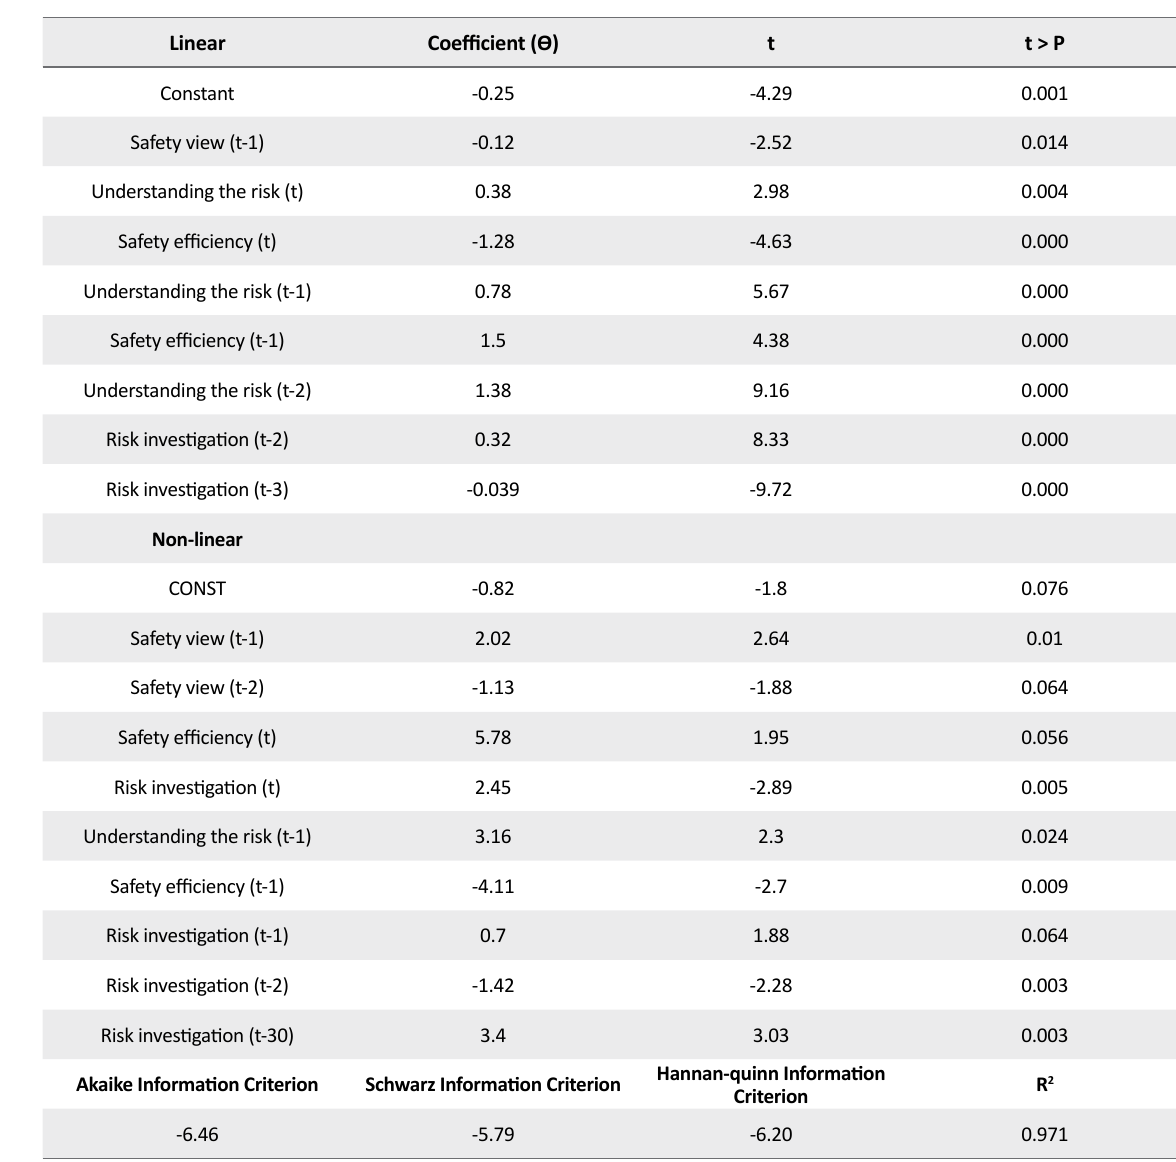
Table 7. The final estimation of the